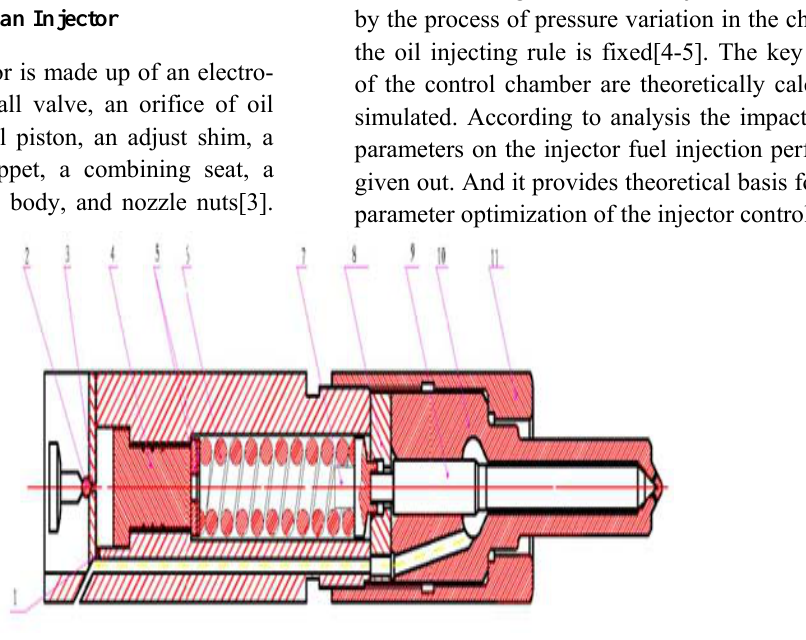
Fig.1 The structural drawing of an injector1-orifice of oil feeding 2-sealing ball valve 3-orifice of oil return 4-control piston 5-adjust shim 6- press-adjusting spring 7-tappet 8-combining seat 9-needle valve 10-needle-valve body 11-nozzle